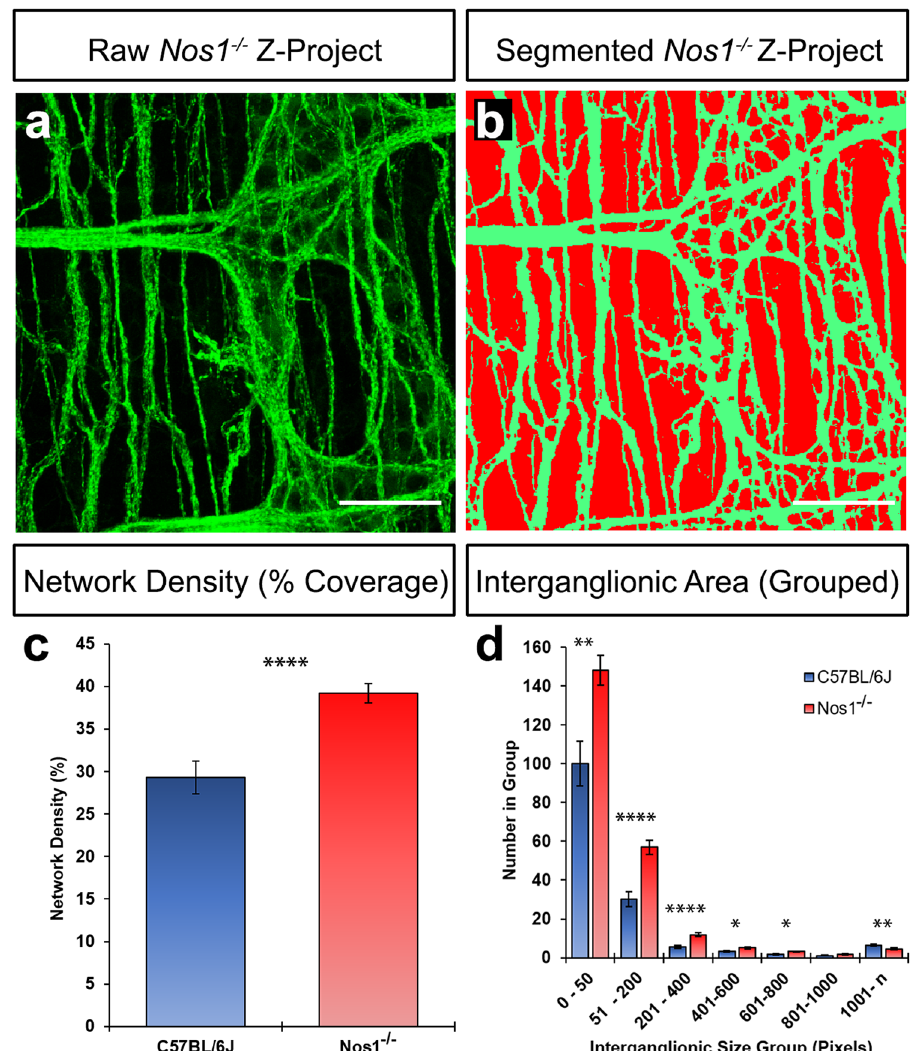
Figure 4. The Nos1 −/− distal colon displays increased ENS coverage. ( a ) Representative confocal z-project demonstrating the TuJ1 + (green) network in the Nos1 −/− distal colon. ( b ) Representative image of digitally segmented image in a showing pseudocoloured TuJ1 + neural network (green) and “interganglionic” regions (i.e., background; red). ( c ) Summary data showing network density (%) in C57BL/6J (blue bar) and Nos1 −/− (red bar) mice. ( d ) Summary data showing the number of binned interganglionic areas (pixel units; pxls) in C57BL/6J (blue bar) and Nos1 −/− (red bar) distal colon. Bins represent very small (0–50 pxls), small (51–200 and 201–400 pxls), medium (401–600 and 601–800) and large (801–1000 & 1000-n) interganglionic areas. *P ≤ 0.05, **P ≤ 0.01, ****P ≤ 0.0001 by Welch’s Student t-test Scale bars, 50